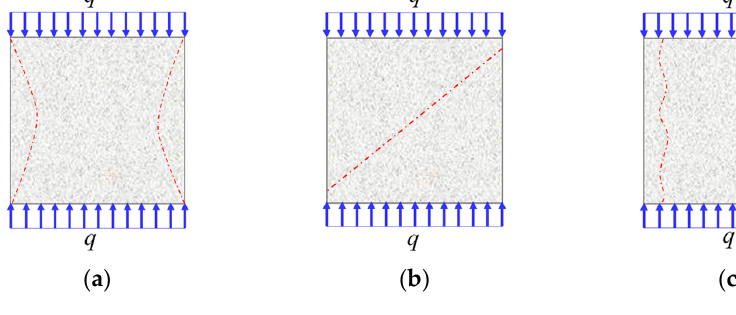
Figure 11. Brittleness and ductility failure modes of backfill: ( a ) X-shaped conjugate inclined plane shear failure; ( b ) Single slope failure; ( c ) Tensile failure; ( d ) Ductile failure.